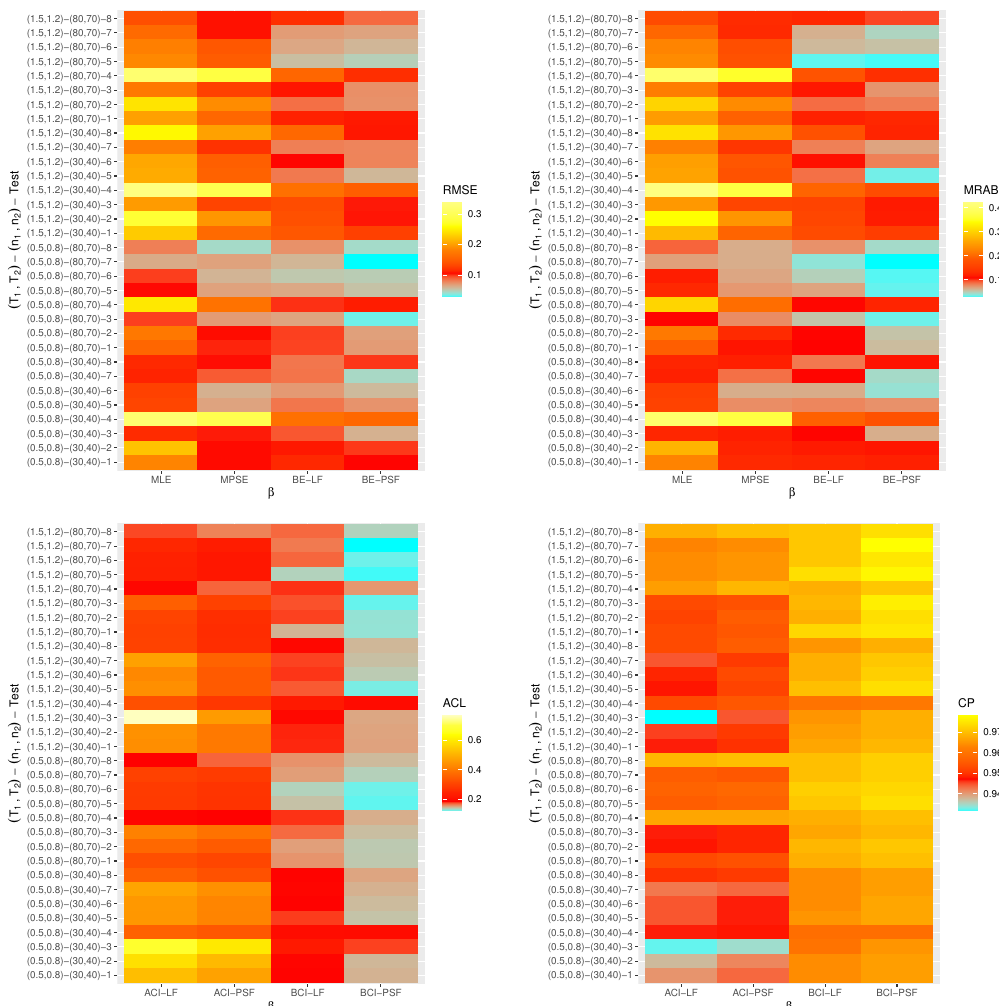
Figure 5. Heatmap for the estimation results of β using Set